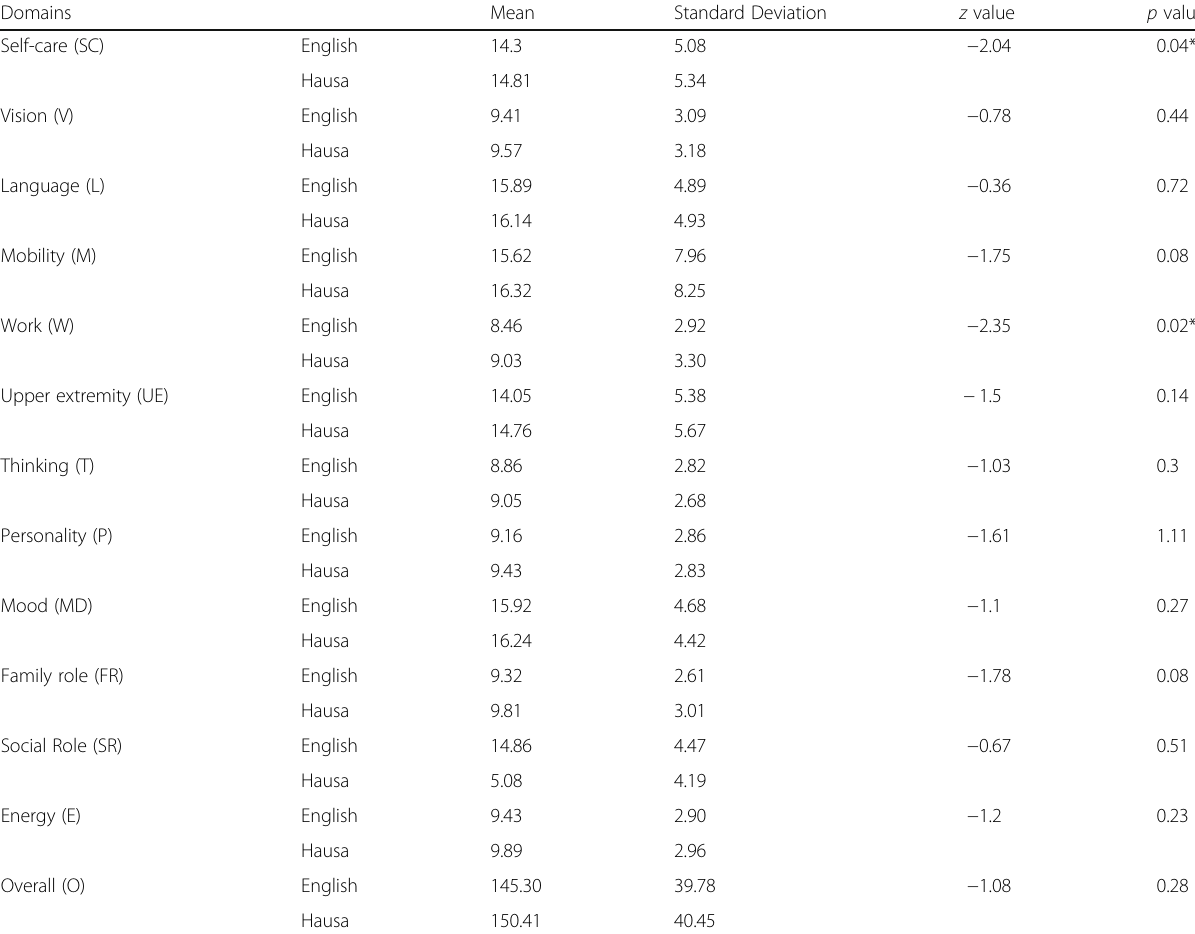
Table 3 Wilcoxon ’ s Signed Rank Test of Participants ’ Scores on the English and Hausa versions of SS-QoL 2.0 scale Domains